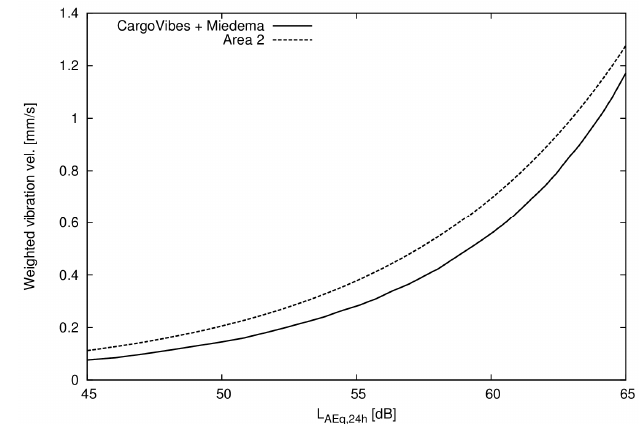
Figure 5. Equal annoyance curves for railway noise and vibration estimated from area 2 compared to results from CargoVibes [4] and Miedema and Oudshoorn [12]. Int. J. Environ. Res. Public Health 2017 , 14 , 805